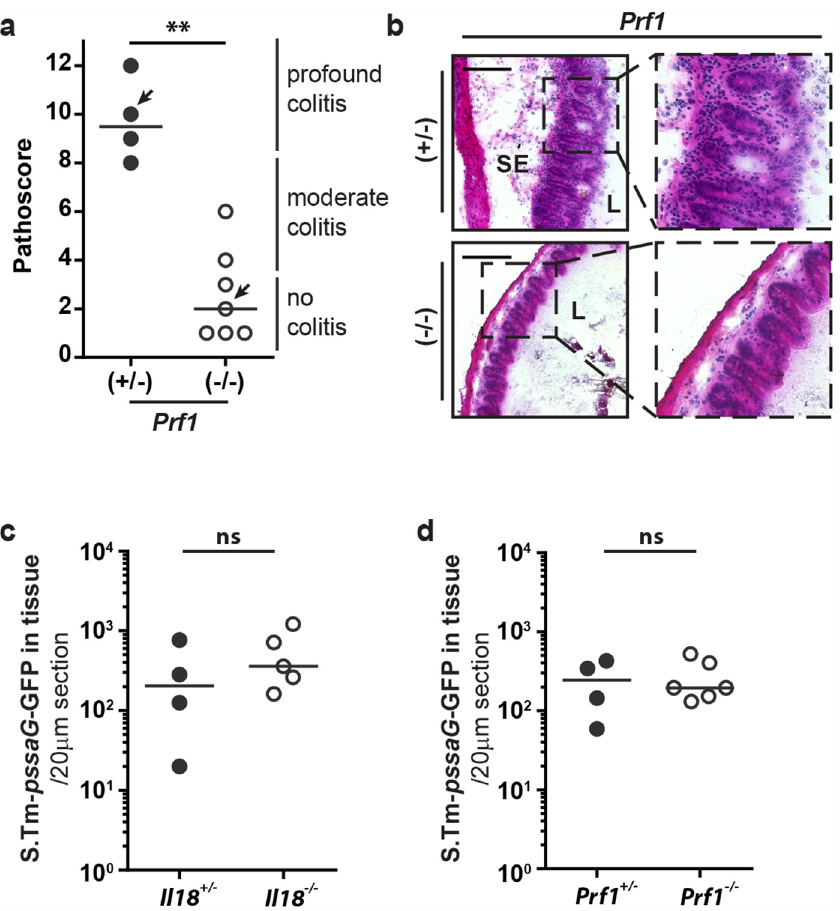
Fig 7. Perforin-deficient mice fail to elicit overt gut inflammation by 12h p.i. (a and b) Prf1 -/- mice and littermate controls were Sm-pretreated and infected orally with 5x10 7 CFU S .Tm for 12h. (a) Pathological score; arrows indicate representative mice depicted in panel b, (b) HE-stained cryosections from representative mice of each group. (c) Il18 -/- mice and littermates or (d) Prf1 -/- mice and littermates were Sm- pretreated and infected orally with 5x10 7 CFU S .Tm-p ssaG -GFPmut2 for 12h (n = 4 – 6 per group). S .Tm cecum tissue counts were determined per 20 μ m cross-section. Statistical analysis was performed using the Mann-Whitney-U test ( ** = p <